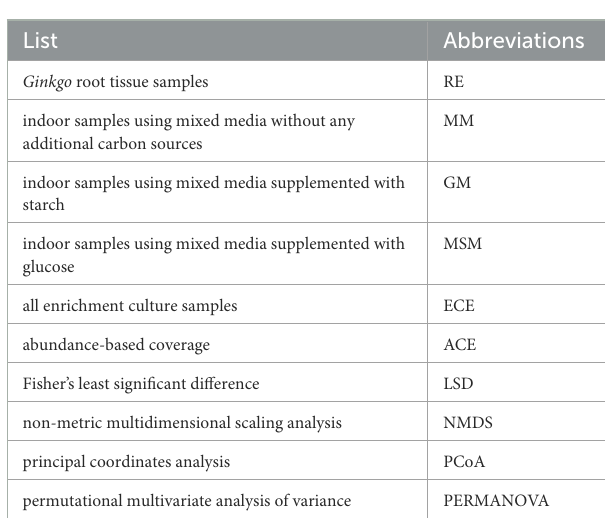
TABLE 1 The list of